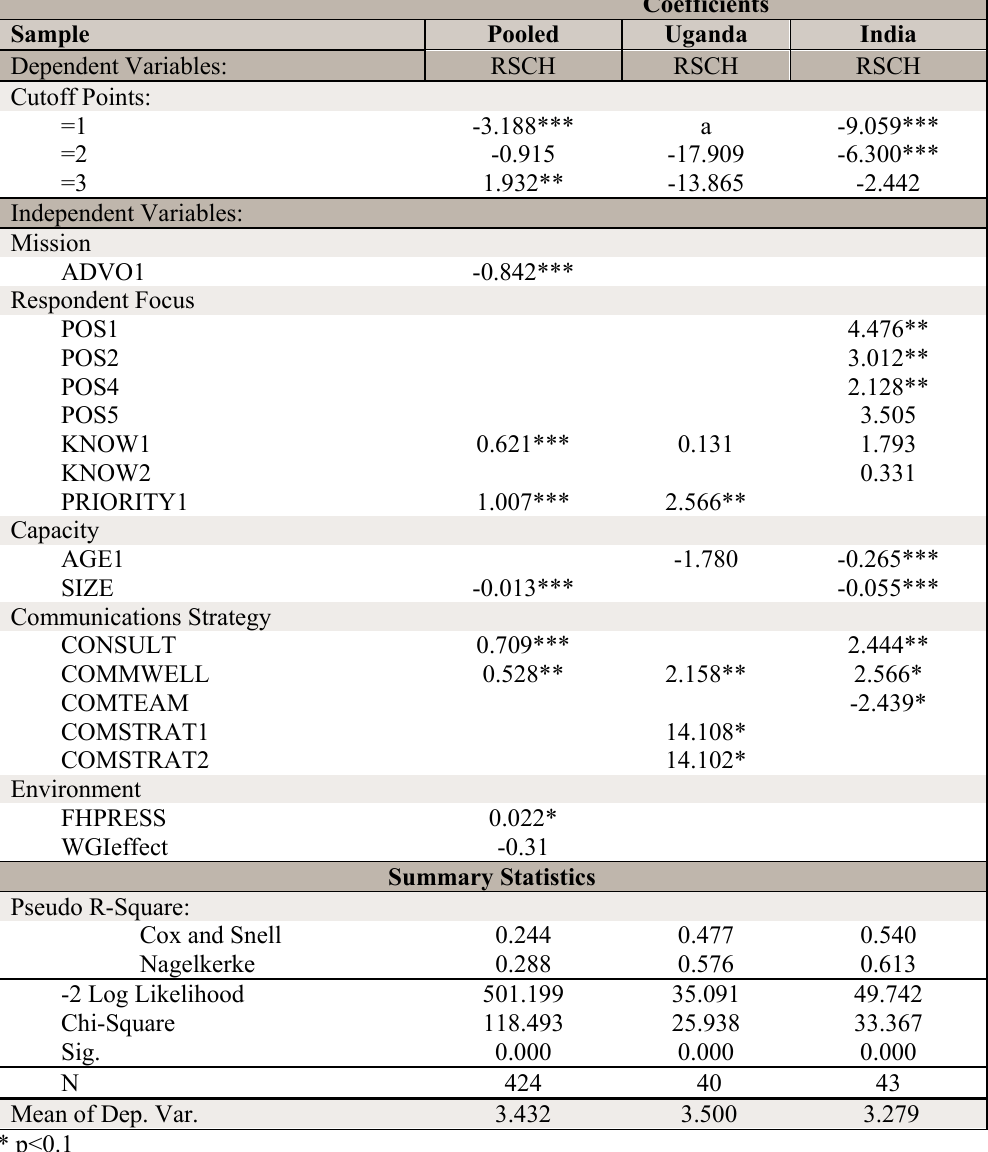
Table 7. Estimated Models for RSCH Using Pooled, India, and Uganda